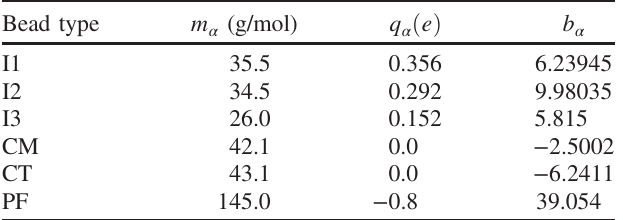
TABLE I. Beads specifications including type, mass, charge, and associated neutron scattering length, in the indicated units.